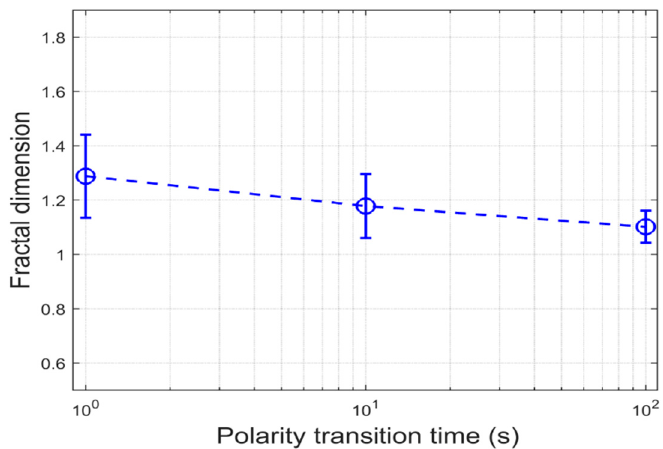
Figure 8. Fractal dimension as a function of polarity transition time.